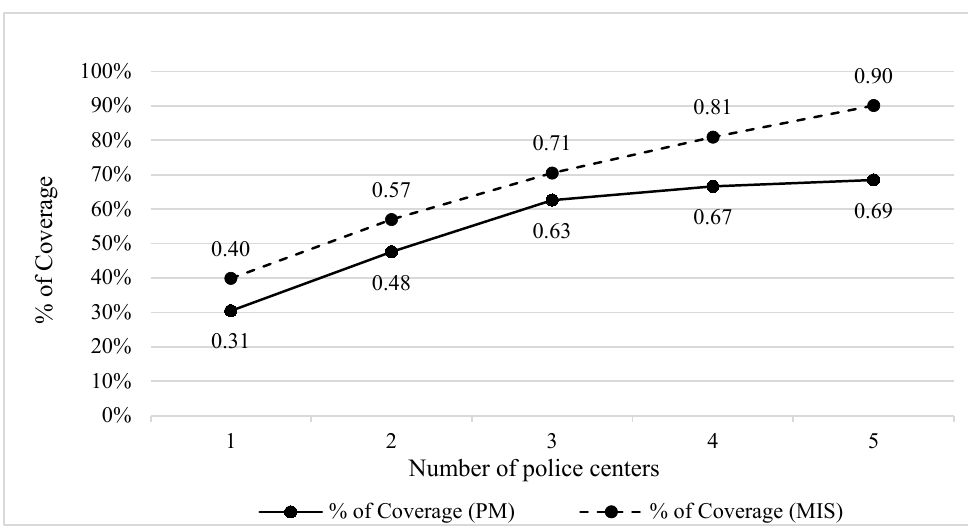
Figure 9. Performance comparison (coverage).